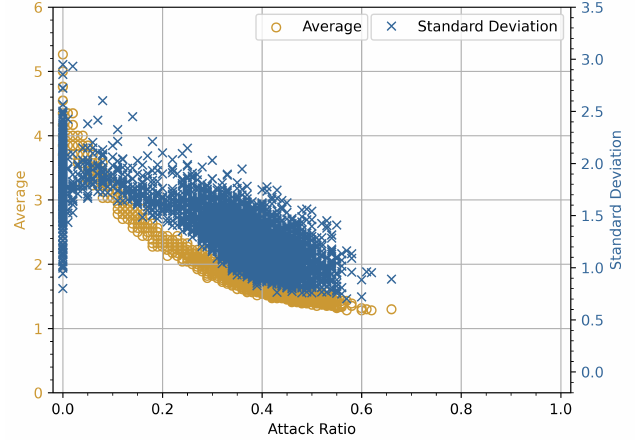
Figure 4. Experimental results of attack ratio vs. average and standard deviation for fuzzy